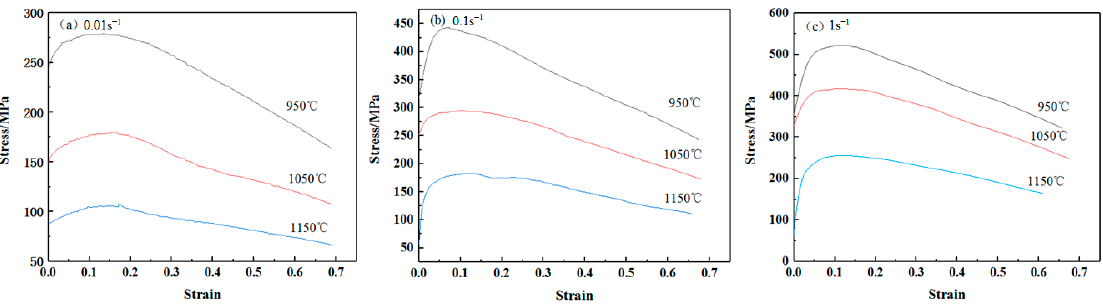
Figure 9. True stress-strain curves of sintered Zr-6Al-0.1B alloy: ( a ) strain rate of 0.01 s − 1 ; ( b ) strain rate of 0.1 s − 1 ; ( c ) strain rate of 1 s − 1 .